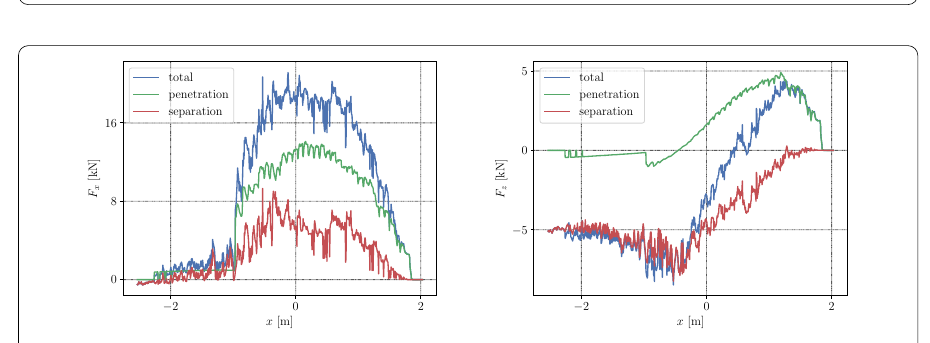
Fig. 16 Force resistance from excavation using three cohesive soils and the microscale model, with snapshot taken at 5 s